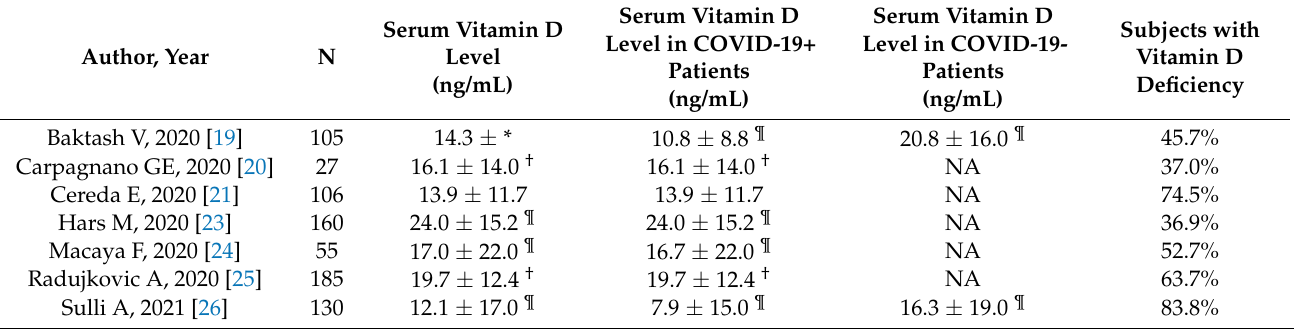
Table 3. Description of vitamin D status in elderly patients with and/or without COVID-19.